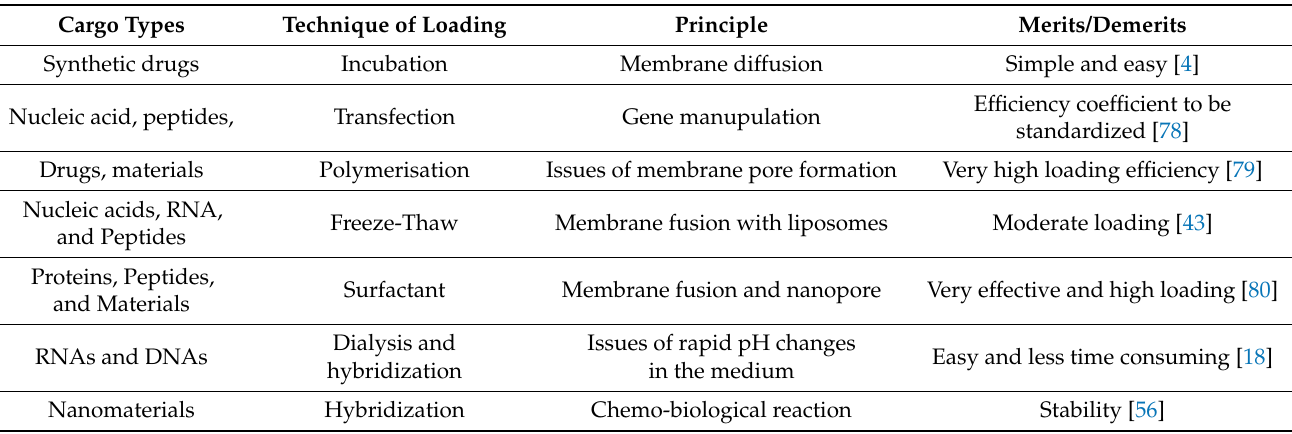
Table 2. Metabolites loading patterns during exosome